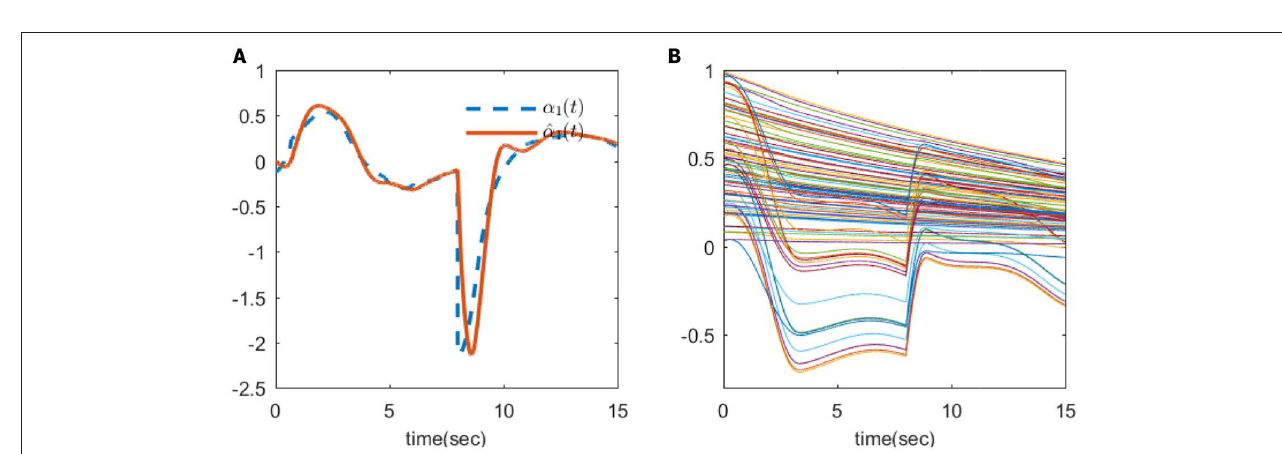
FIGURE 2 | Simulation1 results in (A) e 1 ( t ) and e 2 ( t ); (B) ˜ e 1 ( t ) and ˜ e 2 ( t ); (C) u ( t ) and sat( u ( t )); (D) x d ( t ) and x 1 ( t ).